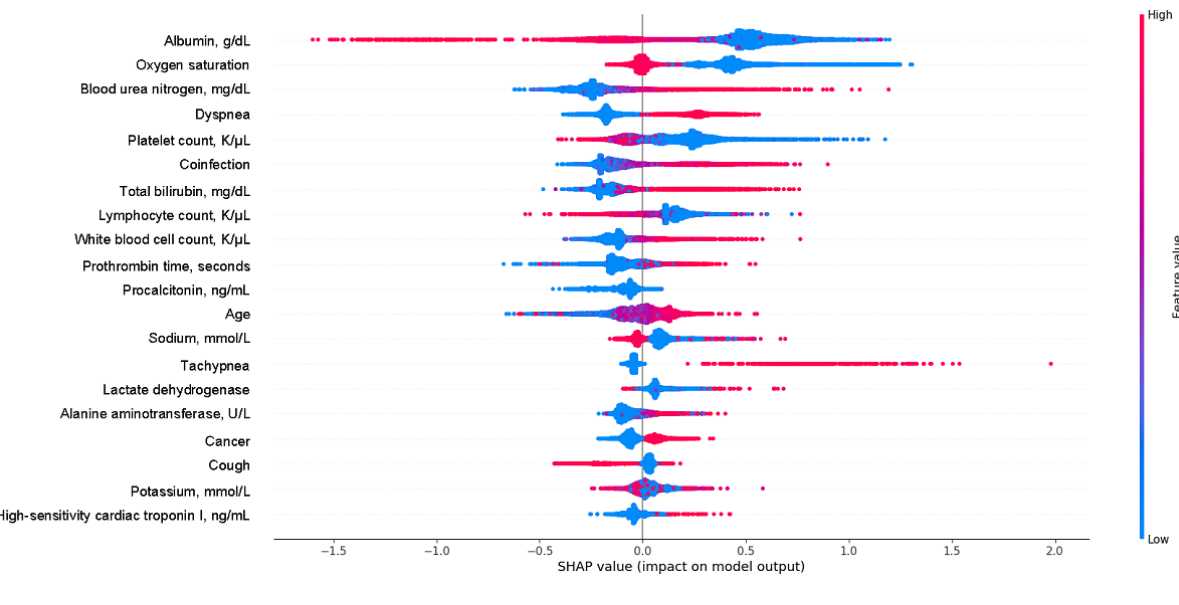
Figure 5. SHapley Additive exPlanations (SHAP) scores of the mortality prediction model. The color indicates whether the value of the feature is high (red) or low